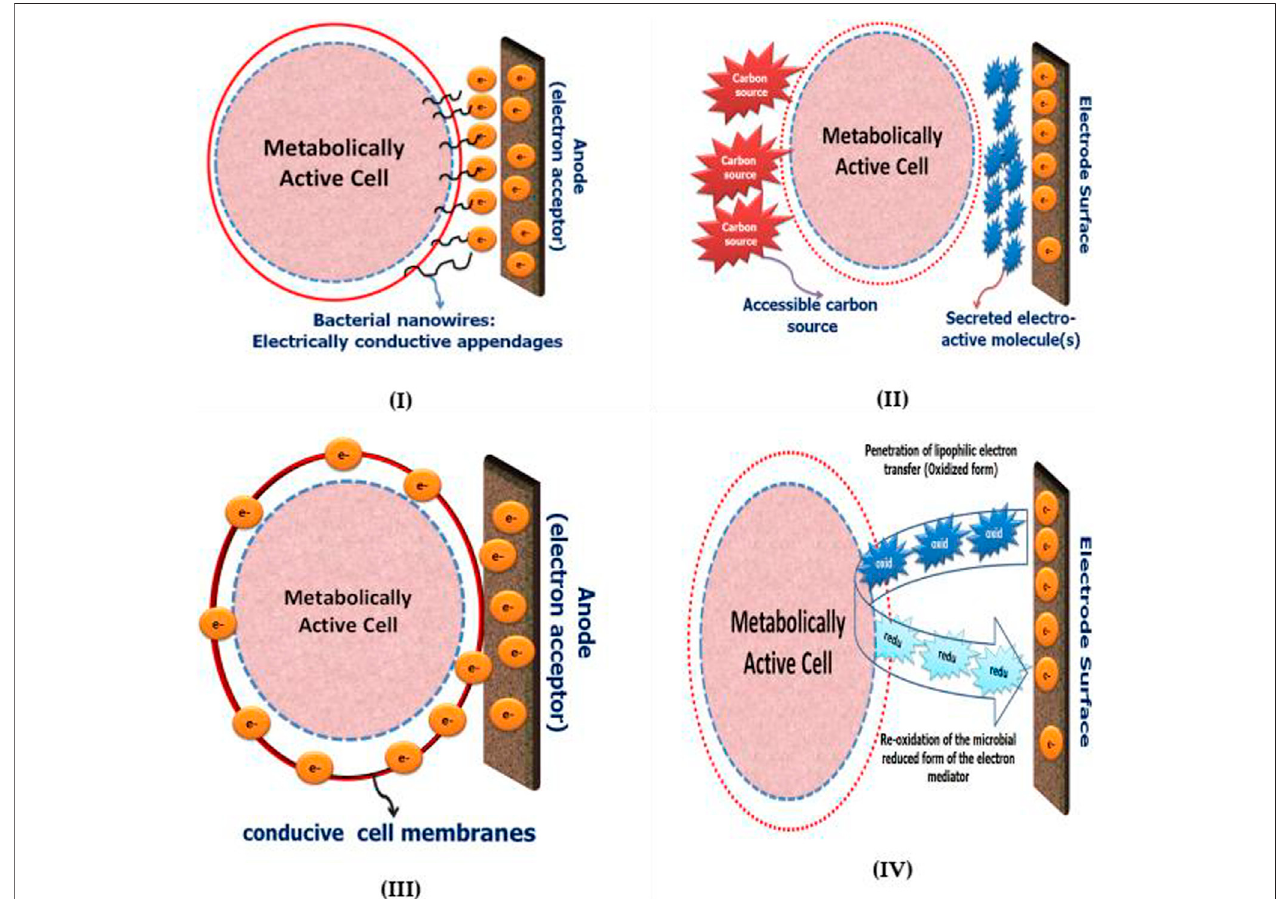
FIGURE 6 | Extracellular electron transport in microbial electrochemical systems is depicted. The creation of a conductive layer at the microbial cell wall or the growth ofnanowires(I)permitsdirectmicrobialelectrotransfer(DET)(III).Thenaturallyreleasedmediators(II)orchemicallyusedelectron redox-shuttleswereusedinthe mediated transfer of electrons (MET) (IV) (Hassan et al.,